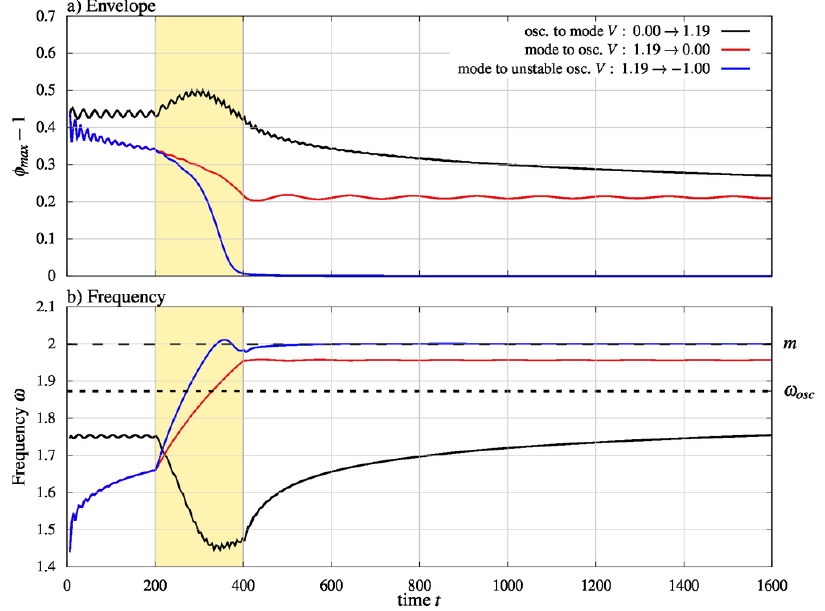
JHEP01(2018)101 Figure 7 . Examples of adiabatic transformations: (i) the oscillon A 0 = 0 : 6 to the internal oscilla- tional mode (black curve); (ii) the oscillational mode to the oscillon (red curve); (iii) the oscillational mode to an unstable oscillon and its consequent decay (blue curve). Figure 8 . Upper plot: amplitude measured after about t = 2000 from initial data with (cid:11) = 0 : 4 as a function of V 0 . Bottom plot: measured frequency of the (cid:12)nal state. The dashed line represents the frequency of the bounded mode of the corresponding potential at A 0 = 0. { 13